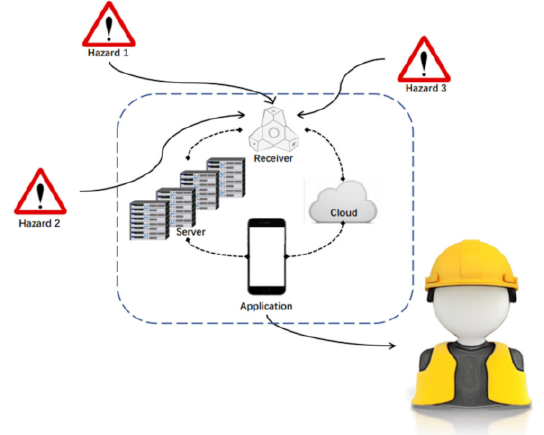
Figure 1. Overview of the design rationale.